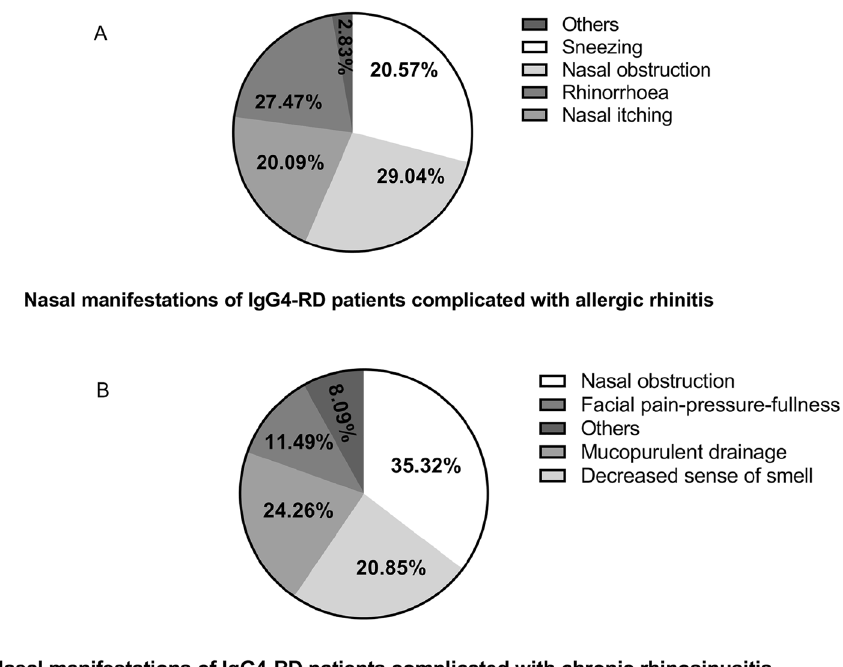
Figure 2. Nasal manifestation of IgG4-RD patients complicated with AR (Group A) and CRS (Group B). ( A ) Patients complicated with AR showed sneezing, nasal obstruction, nasal itching and rhinorrhea most commonly. ( B ) Patients complicated with CRS showed nasal obstruction, decreased sense of smell, mucopurulent drainage and facial pain-pressure-fullness most commonly. IgG4-RD, IgG4-related disease; AR, allergic rhinitis; CRS, chronic